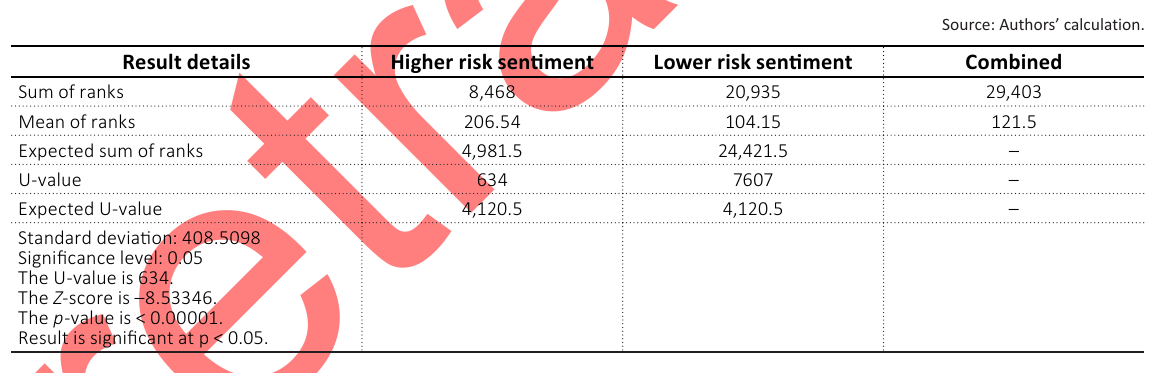
Table 4. Mann-Whitney U-test for age factor